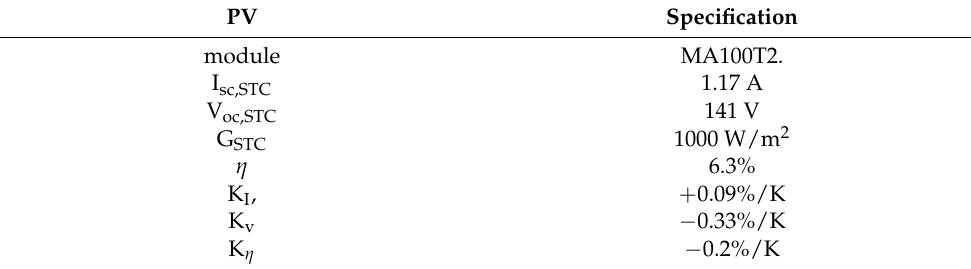
Table 1. Parameters from datasheets.